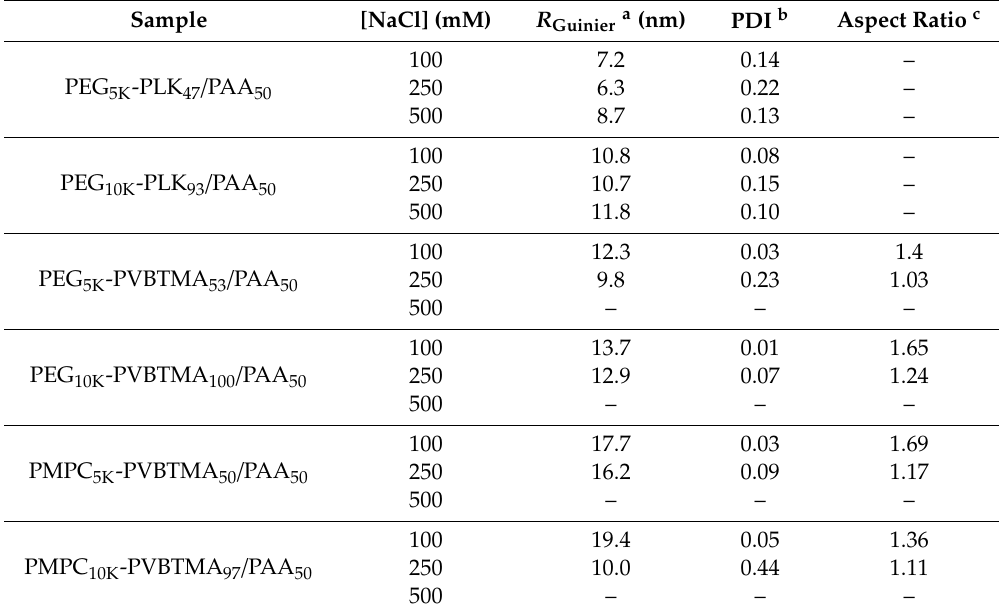
Table 3. Small-angle X-ray scattering (SAXS) model parameters summary with added